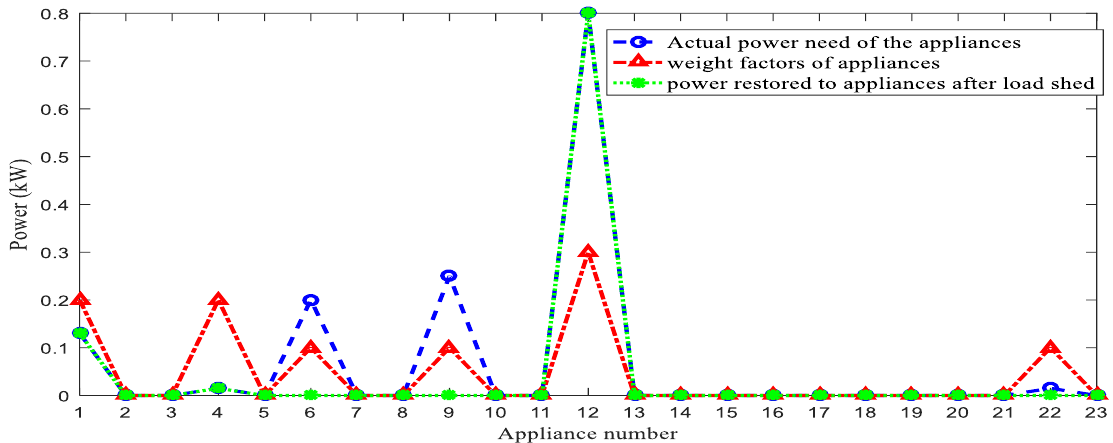
Figure 11. Actual load to meet, weight factors assigned for priority of appliance, and power restored due to EVs for residential user 5.